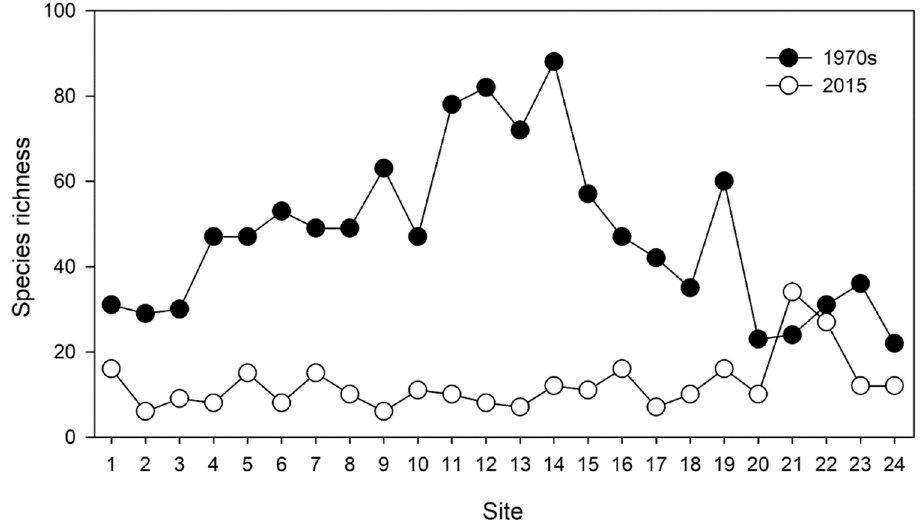
Figure 2. Species richness at various sites in space of the Min River at two different periods: the 1970s and 2015.